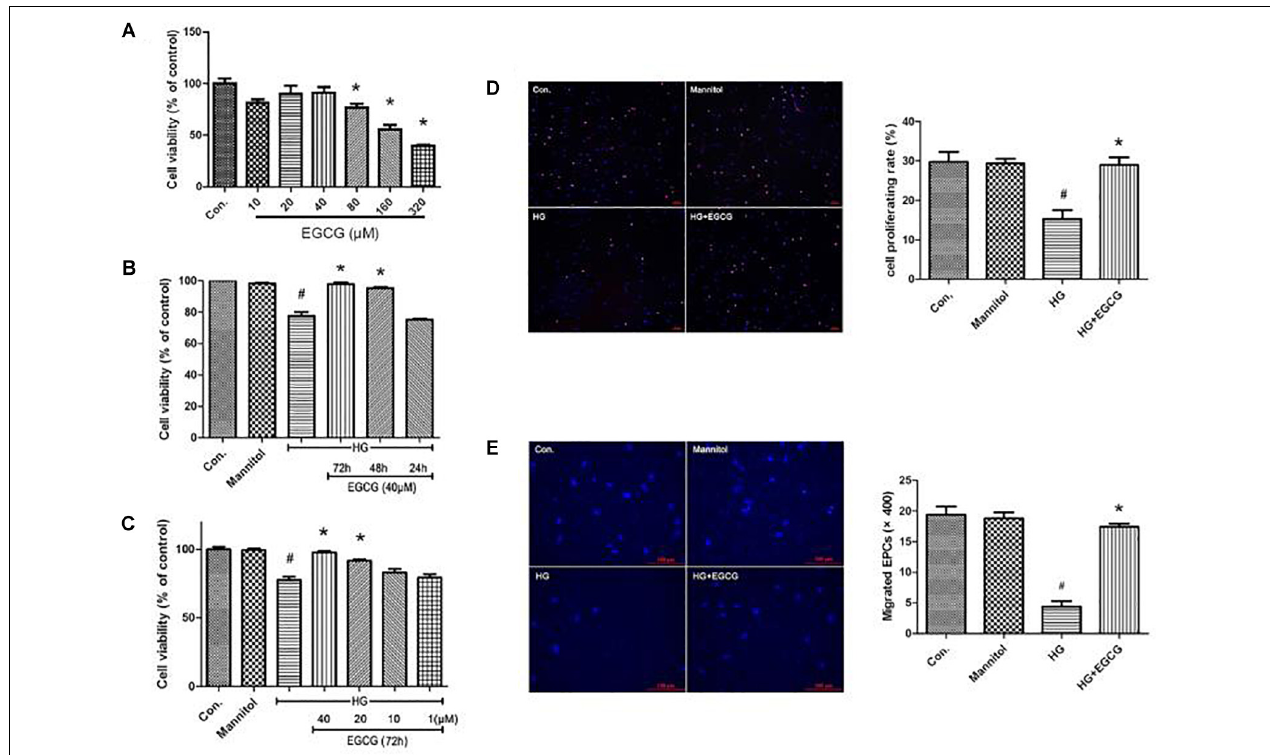
FIGURE 4 | EGCG improves L-EPCs proliferation and migration under high glucose condition. (A) CCK-8 test reveals that up to 40 µ M EGCG shows no poisonousness to L-EPCs, the typical IC50 of the chemical is 320 µ M. ∗ P < 0.05 compared to control group. (B,C) L-EPCs incubated in high glucose environment (30 mM) were co-incubated under different concentrations of EGCG (1–40 µ M) for different time (24–72 h). Histogram reveals that high glucose treatment for 72 h directly impairs the proliferation of L-EPCs, this impairment could be block by EGCG in a time and dose dependent manner. # P < 0.05 compared to the control group, ∗ P < 0.05 compared to the high glucose (HG) group. (D) EDU incorporation assay ( × 100 magnification). In the image overlay, the purple nuclei stained with EDU, indicates proliferating cells, while the blue nuclei are Hoechst 33342 stained, # P < 0.05 compared to the control group, ∗ P < 0.05 compared to the HG